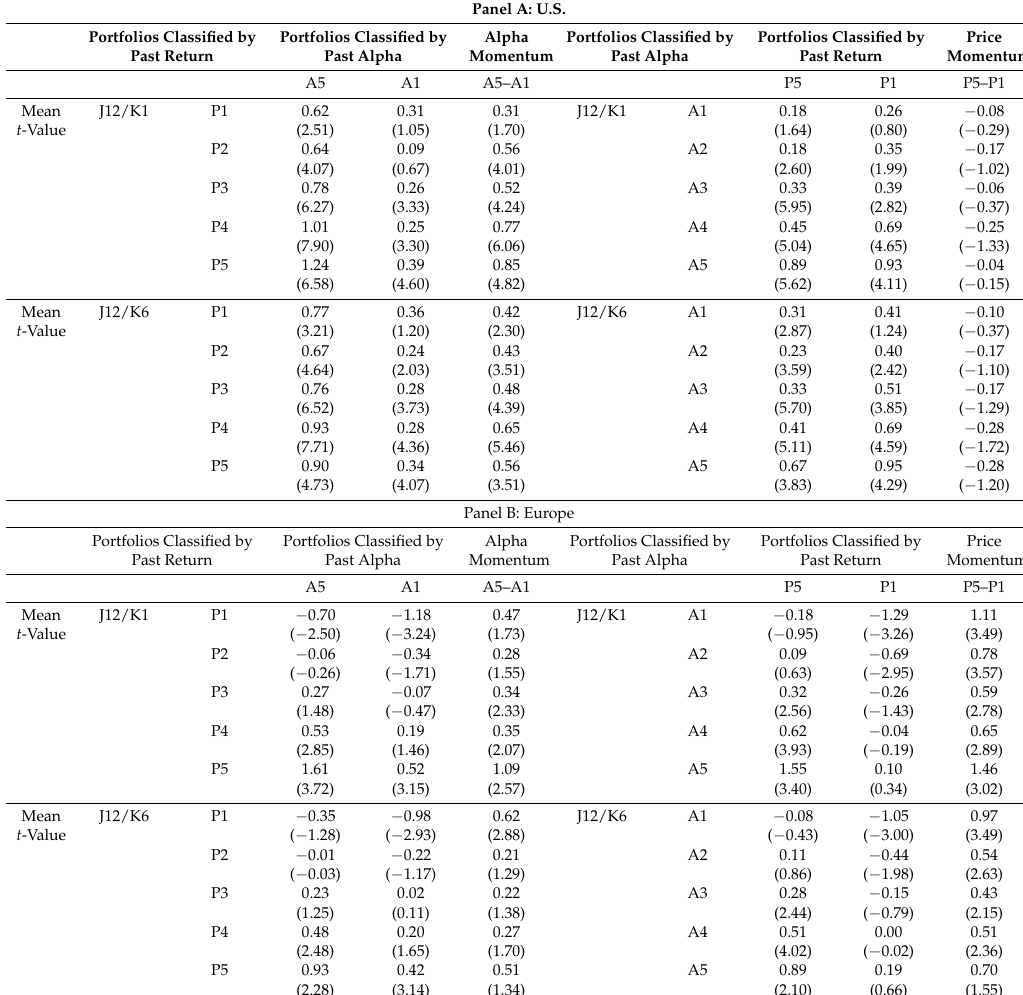
Table 3. Monthly risk-adjusted returns of two-way dependent sorts on past return and past alpha. Panel A: